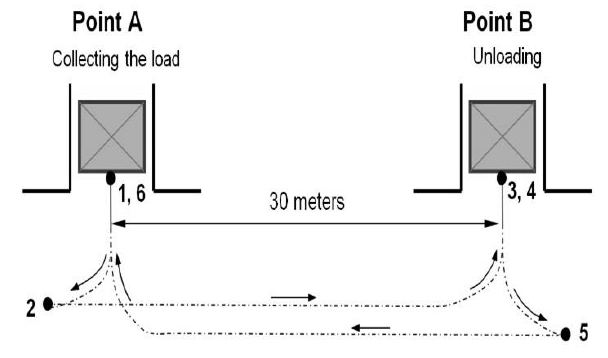
Fig. 5. Scheme of the research cycle